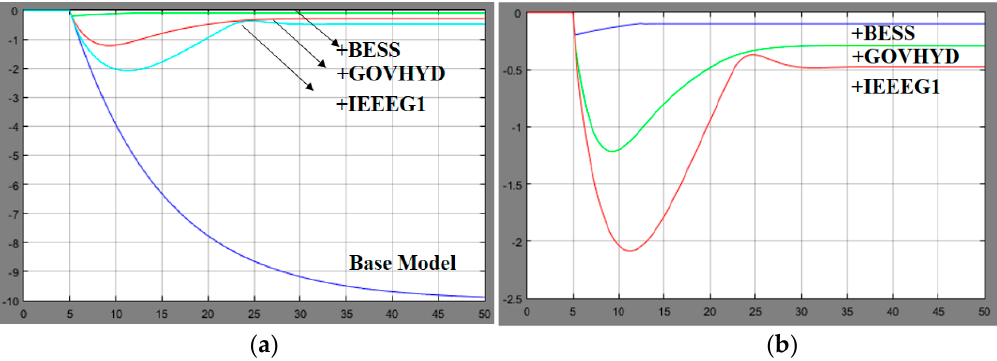
Figure 21. The frequency characteristics of each compensation equipment: ( a ) Compensation facility characteristics; ( b ) Compensator characteristics.